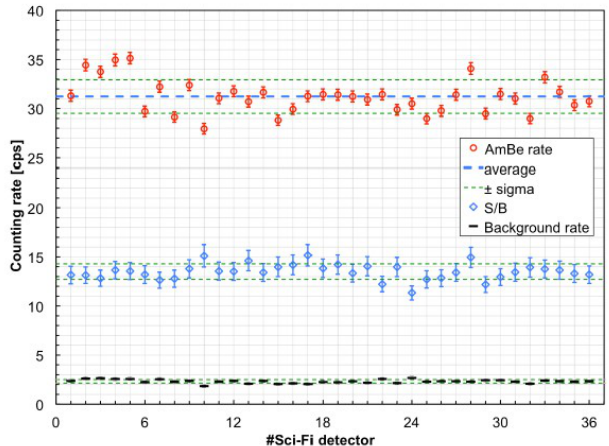
Fig. 10. The counting rate measured on top of the AmBe source box the background rate and the signal to background ratio of the 36 SciFi detectors For each detector, the ratio between the observed count rates with 137 Cs and the AmBe sources, respectively, was also calculated. The results, plotted in Fig. 11, indicate a quite reasonably constant behaviour of this ratio.